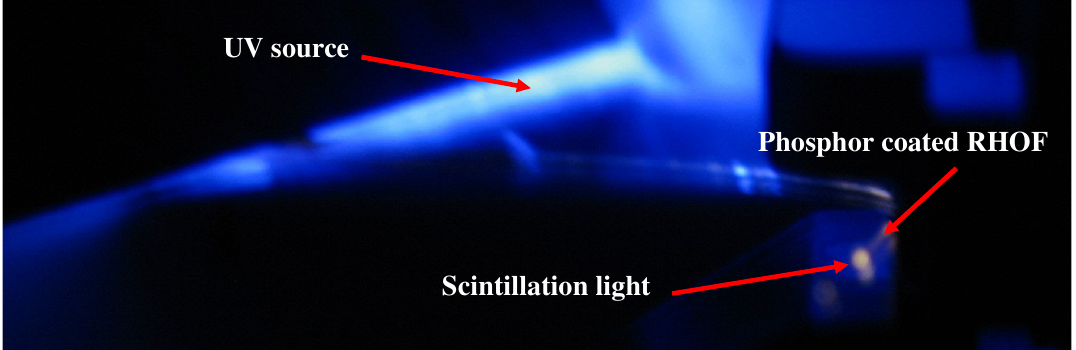
Figure 8. Phosphor response to UV in the coated RHOF